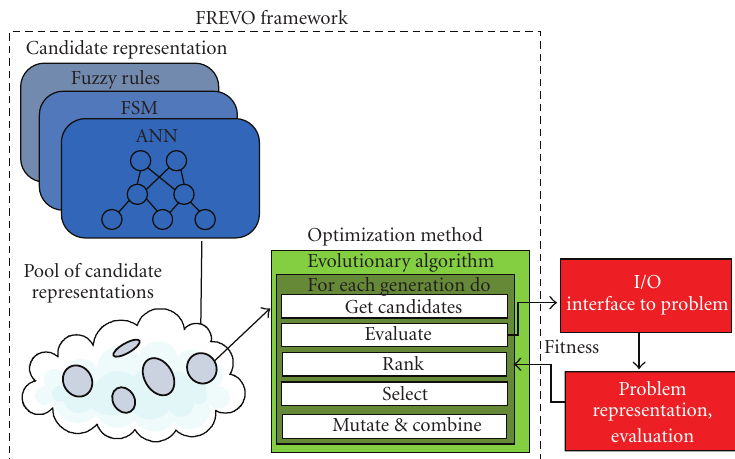
Figure 1: Components of the FREVO framework: The agent representation is optimized by the evolutionary algorithm to maximize the fitness for the given problem.